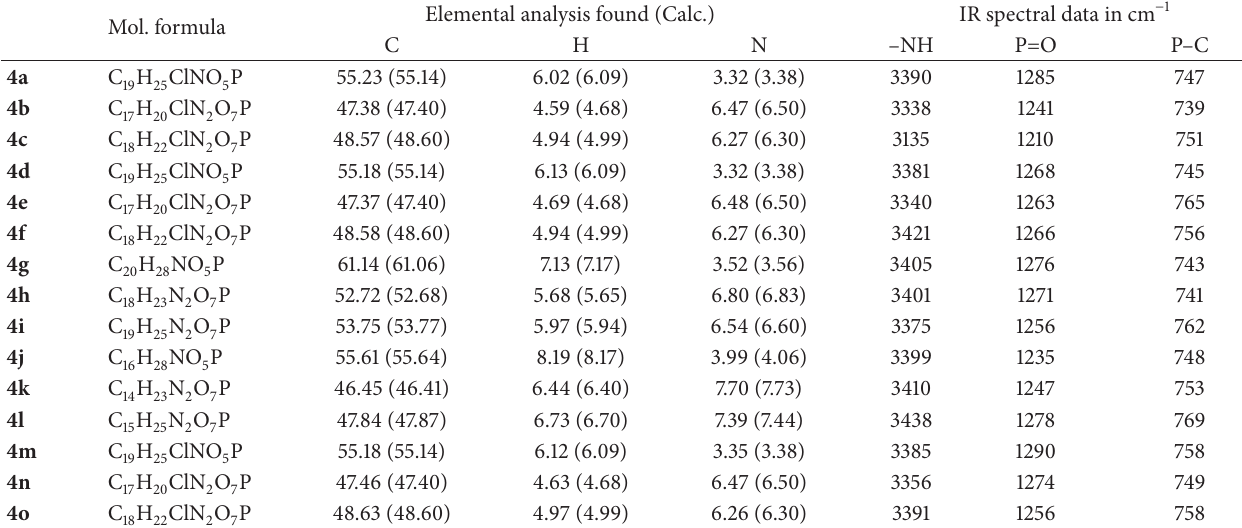
Table 2: Elemental analysis and IR data of compounds ( 4a–o ).